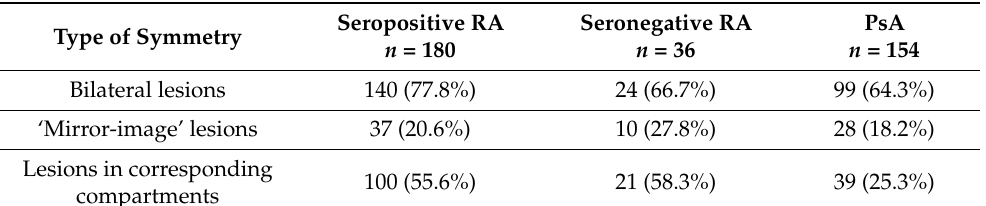
Table 2. The occurrence of symmetric lesions on hand radiographs of analyzed patients with seropositive RA, seronegative RA, and PsA.